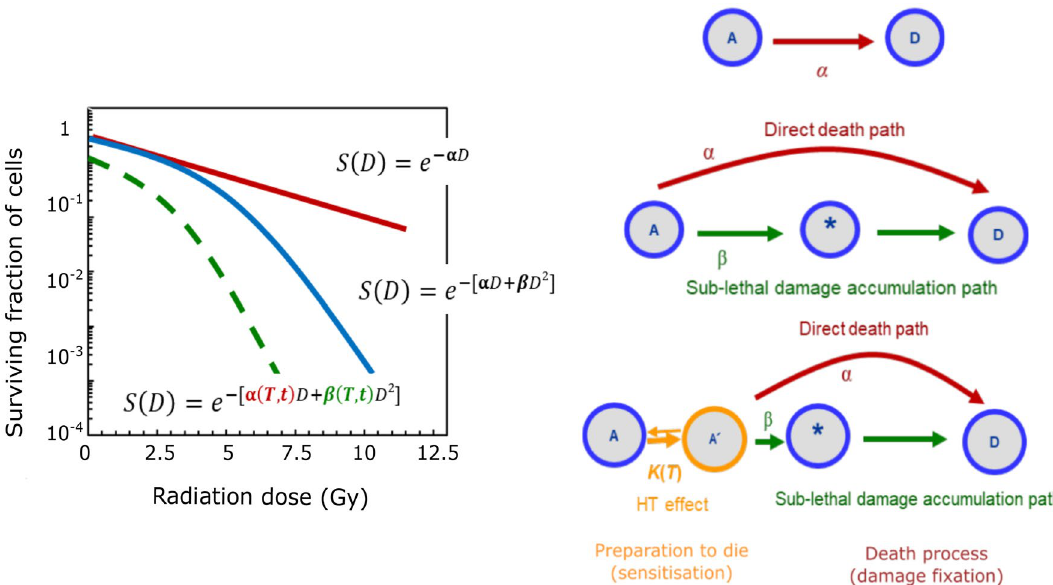
Figure 1. Left: Schematic survival probabilities for the three cases depicted on the right. ( a ) Cell killing as a single rate process with transition rate from alive ( A ) to dead ( D ) α . ( b ) Two-step cell killing process in the LQ-model for radiation. A cell transits from the alive state ( A ) to the dead state ( D ) through two possible paths: α for direct killing (a single hit suffices to kill), and β for indirect killing (when two hits are required to kill). ( c ) Combined HT+RT: HT-induced damage elevates cells from state ( A ) to an activated state ( A ′ ), effectively reducing the α/β ratio. Since β is more efficiently reduced, the direct path α dominates the killing process and consequently reduces the survival